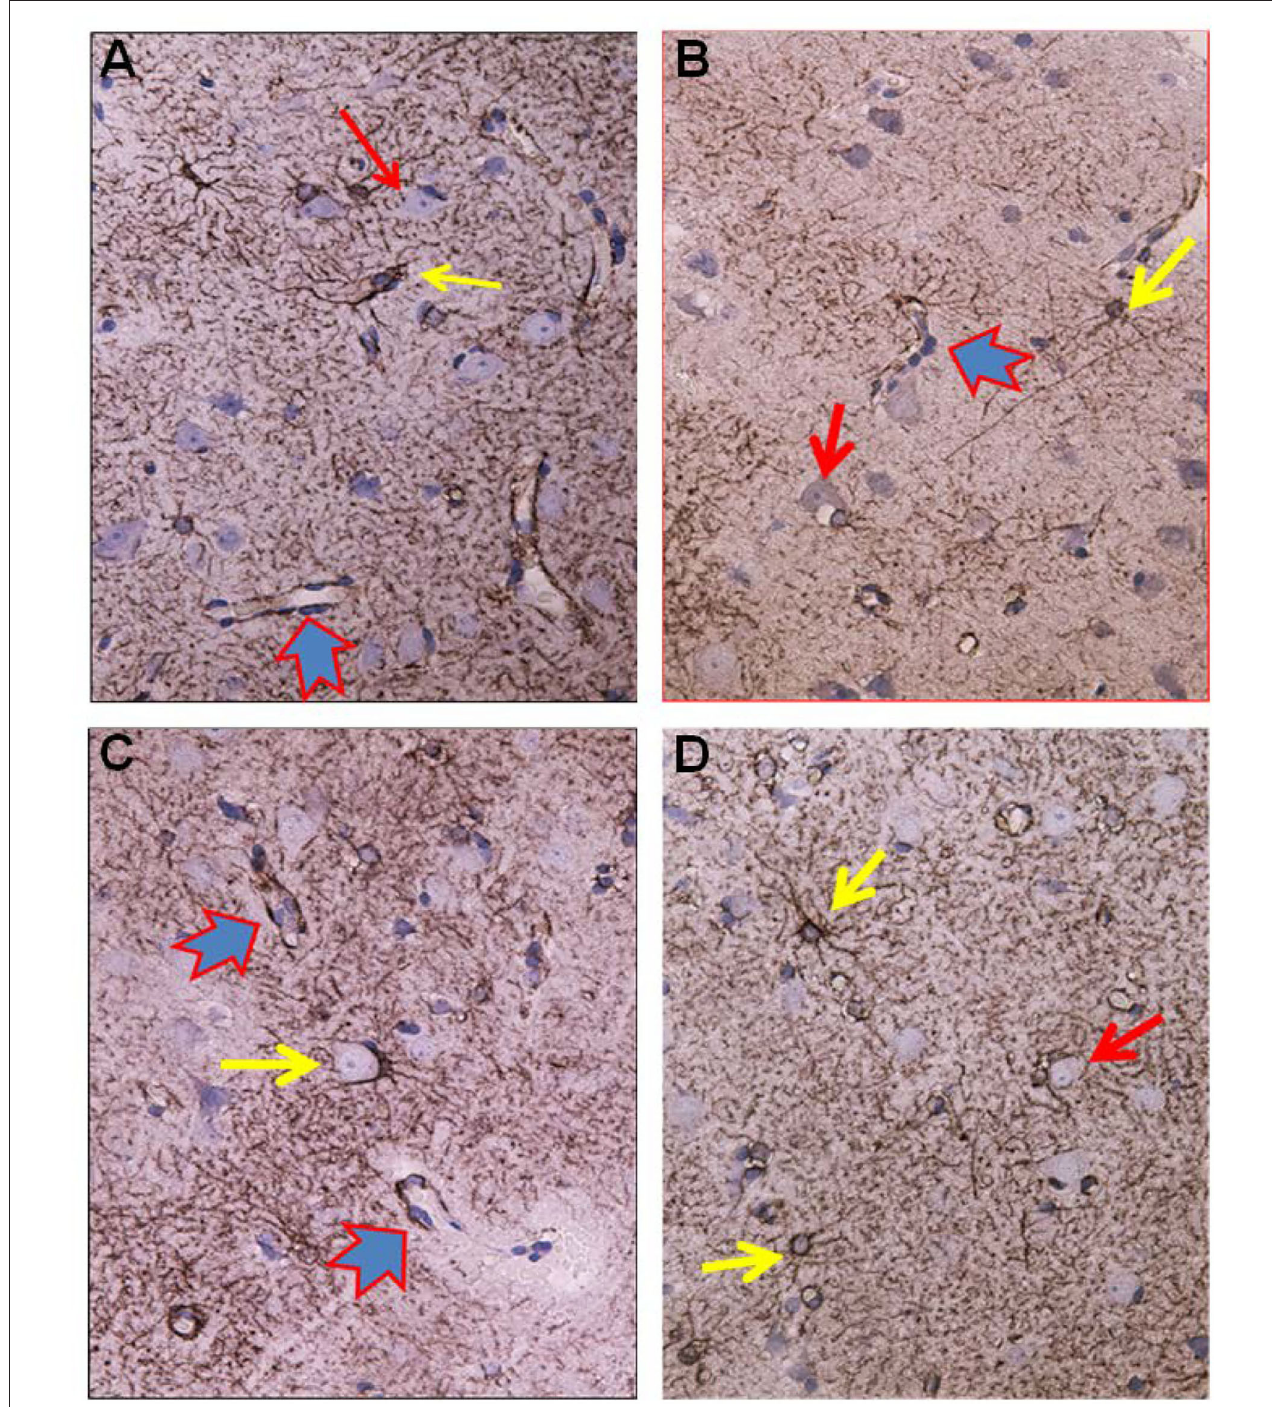
FIGURE 5 | Visualization of astrocytes by GFAP-IR in cerebral cortex of IIH patients. (A) GFAP-IR is demonstrable forming an elaborated meshwork of processes and membranes. Note the swelling of the perivascular astrocytic end-feet along small blood vessels (red-blue arrow). Nerve cell marked by red arrow and astrocytes marked by yellow arrow. (B) Enlarged astrocyte end-feet, filled up by GFAP-IR material, were demonstrable along small blood vessel. The function, effects and importance of such enlarged GFAP-IR end-feet accumulations require further investigation. (C) The large nerve cell in the center (yellow arrow) is delimited by astrocyte membranes along its cell body. This is characteristic for synaptic stripping where the GFAP IR membrane continuously encloses half of the perikaryal circumference of the nerve cell body. Note that GFAP-IR profiles are demonstrable in only parts of the cortex specimen. Enlarged GFAP-IR end-feet marked by red-blue arrows. (D) Examples of close approximation between the astrocyte processes and the nerve cells. Further, the intensely stained GFAP-IR processes radiate from the astrocyte cell body, divide, and additionally entered neighbor cell domains. Red arrow toward nerve cell and yellow arrows toward astrocytes.